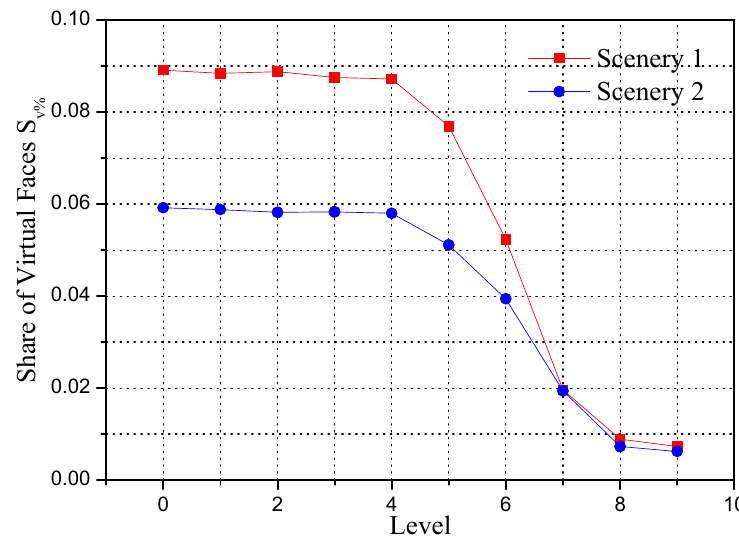
Figure 9. When the LOD level is not larger than 4, the proportion of virtual faces is stable and close to the largest values, as expected. Emphasis on virtual faces is described for the stage of sampling in Section 4.